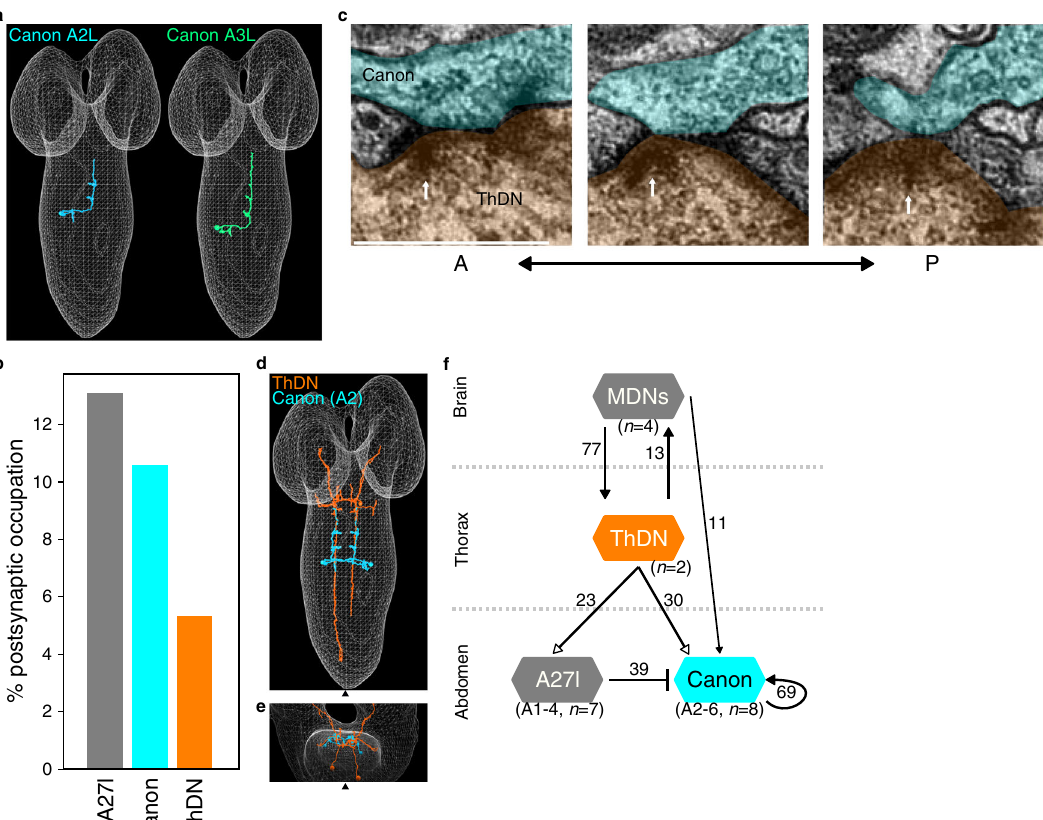
Fig. 4 Upstream circuits of Canon neurons. a EM reconstruction of left side Canon neurons in neuromeres A2 and A3. b A bar graph showing percent of total postsynapses of A2 – A3 Canon neurons that are targeted by the indicated upstream neuron. Major partners (occupying more than 5% of total postsynapses) are shown. c Serial EM images showing synapses between ThDN neuron (presynapse, orange) and A2 Canon neuron (postsynapse, light blue). White arrows indicate T-bars. The images show representative synapses of observed 30 synapses from ThDN to Canon neurons. d , e Dorsal ( d ) and anterior view ( e ) of reconstruction images of ThDNs (orange) and A2 Canon (blue) neurons. Triangles indicate the midline. f A diagram of connectivity from MDN to Canon neurons. Arrows with fi lled heads indicate cholinergic synapses while arrows with empty heads indicate synapses with unidenti fi ed neurotransmitter. The bar indicates inhibitory outputs. Numbers next to the lines show the number of synapses. Scale bar ( c ), 500